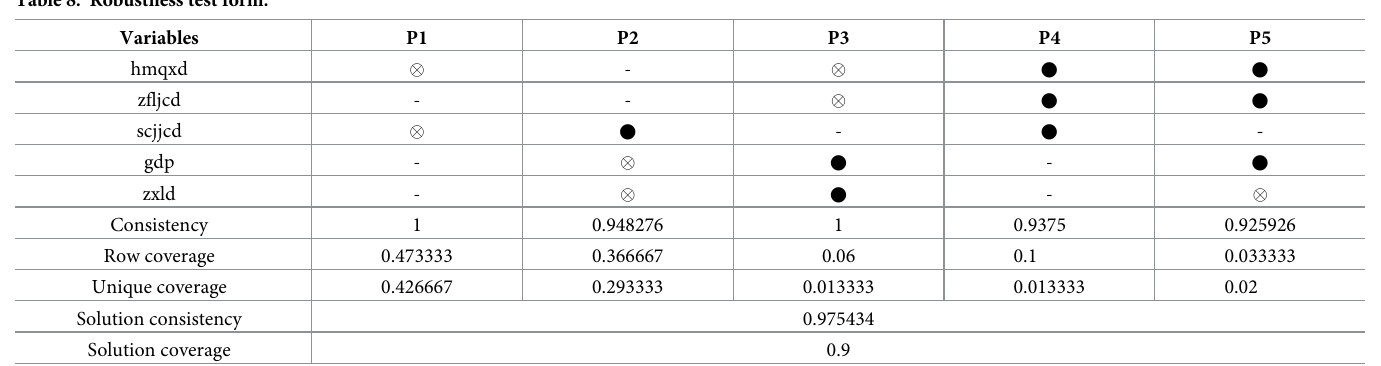
Table 8. Robustness test